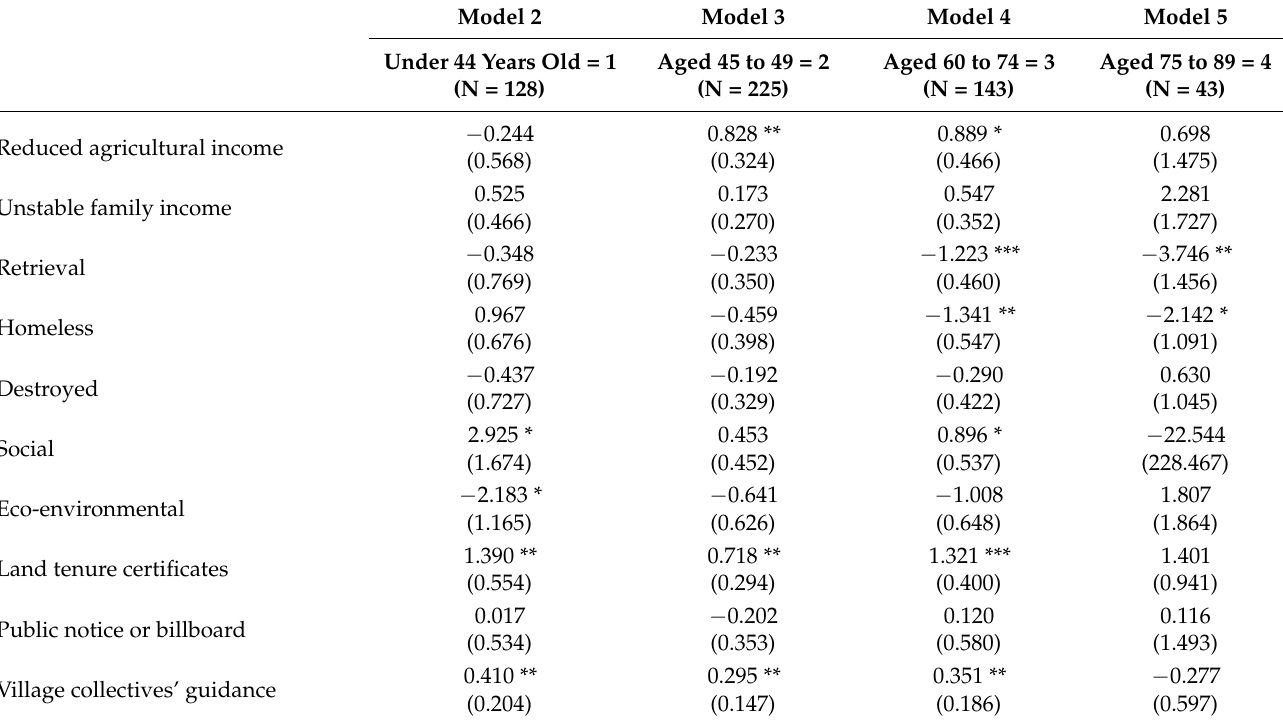
Table 4. Analysis of household age